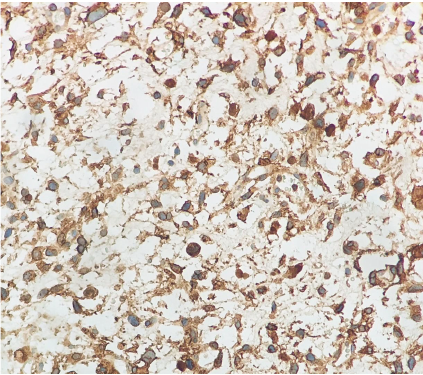
Figure 3: Tumor cells show strong membranous expression of CD10 (CD10 immunohistochemistry, 20x magni fi